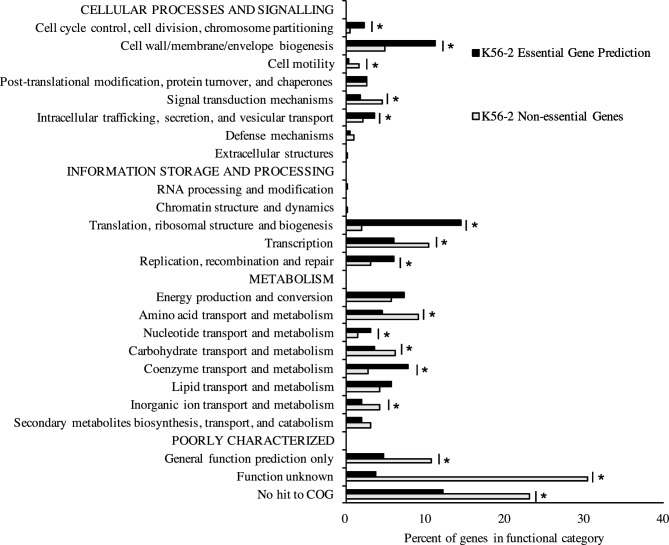
Functional categories of the predicted essential and non-essential genes of B. cenocepacia K56-2 Functional categories are based on the clusters of orthologous groups (COG) [58], which were assigned to genes of B. cenocepacia K56-2 from the corresponding homologous gene in B. cenocepacia J2315. Functional categories significantly enriched or under-represented in the essential gene set are indicated with an asterisk (P<0.05, Fisher exact test).